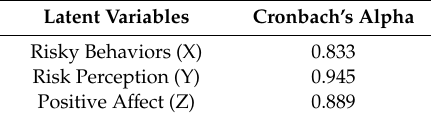
Table 3. Reliability test (Cronbach’s Alpha) of the self-reported